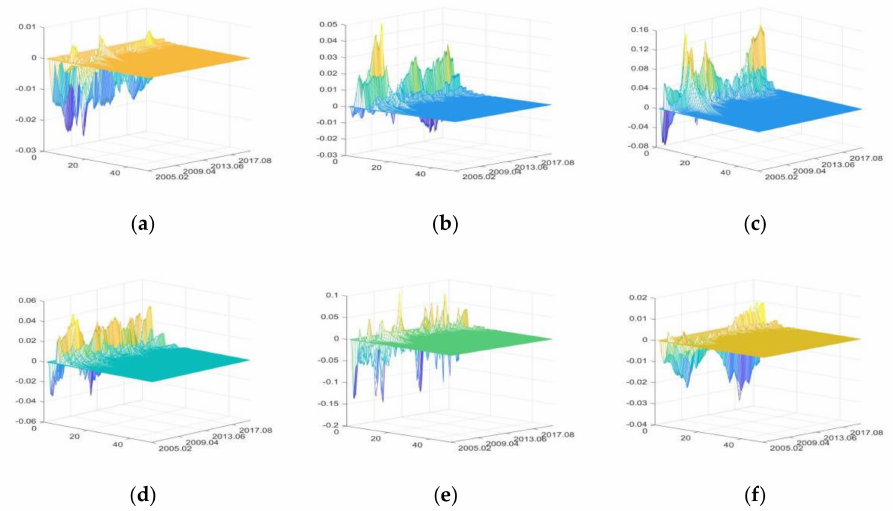
Figure 11. The three-dimensional impulse responses of PMFI to positive shocks of external uncer- tainties. ( a ) Shocks of IRU. ( b ) Shocks of FU. ( c ) Shocks of SDU. ( d ) Shocks of CU. ( e ) Shocks of DE. ( f ) Shocks of